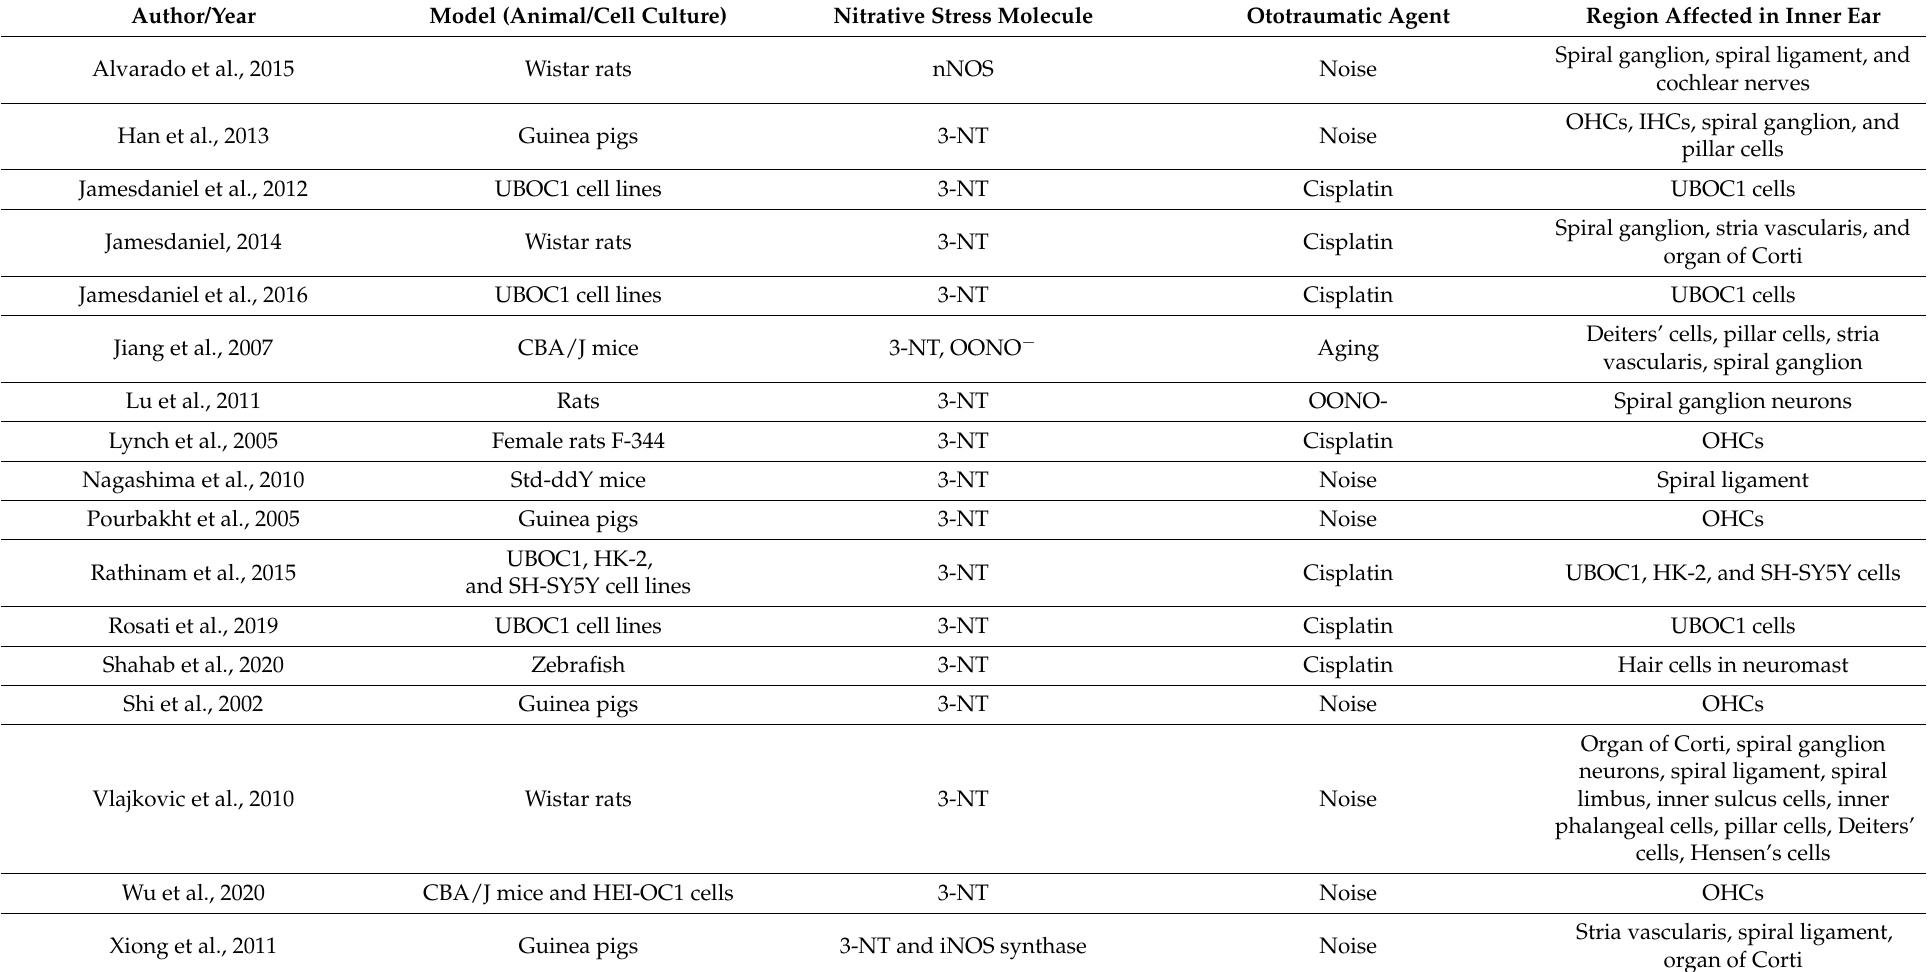
Table 1. Studies showing nitrative stress in auditory